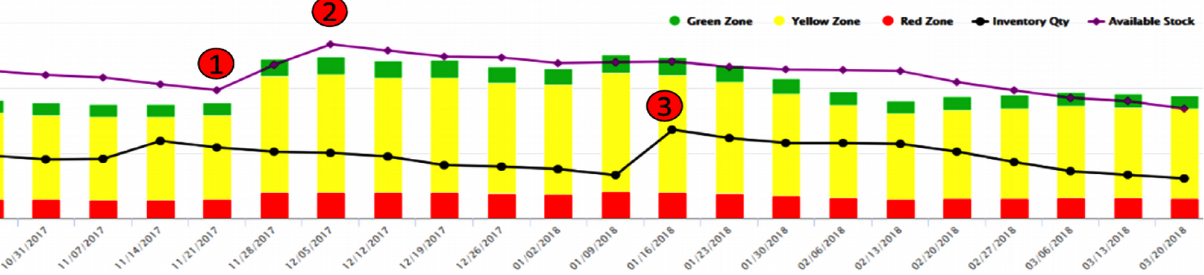
Figure 7. Real buffer evolution implementing a planned